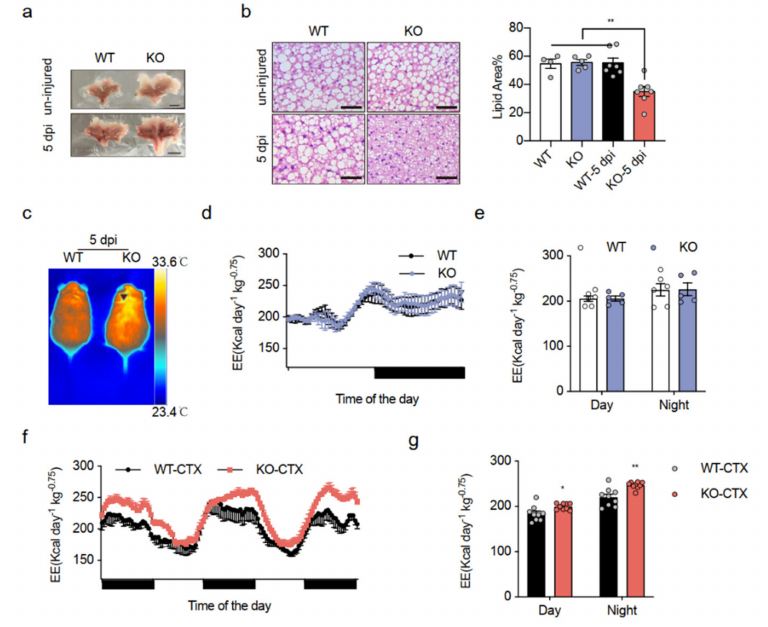
Figure 1. Mice lacking Islr have increased whole-body energy expenditure upon muscle-BAT dialogue: ( a ) representative BAT from WT and KO mice at the age of 10 weeks under uninjured and CTX-injured conditions; scale bar: 0.5 cm; ( b ) Left: histological images of BAT from WT and KO mice at the age of 10 weeks under uninjured and CTX-injured conditions (n = 6); Scale bar: 50 µ m; Right: quantification of H&E staining under uninjured and injured conditions; ( c ) thermal images of WT and KO mice after CTX injury; ( d , e ) indirect calorimetric analysis of EE ( d ) and quantification of EE ( e ) of WT and KO mice under uninjured conditions (n = 5–6); ( f , g ) indirect calorimetric analysis of EE ( f ) and quantification of EE ( g ) of WT and KO mice after CTX injury (n = 9); WT: wild-type mice; KO: Islr-KO mice; 5 dpi: 5 days post injury CTX: cardiotoxin.; BAT: brown adipose tissue; EE: energy expenditure. Error bars represent SEMs, * p < 0.05, ** p < 0.01, as determined by two-tailed Student’s t